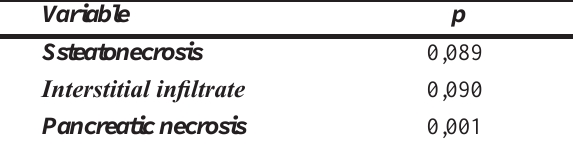
TABLE 4 - Histopathological comparison of the groups